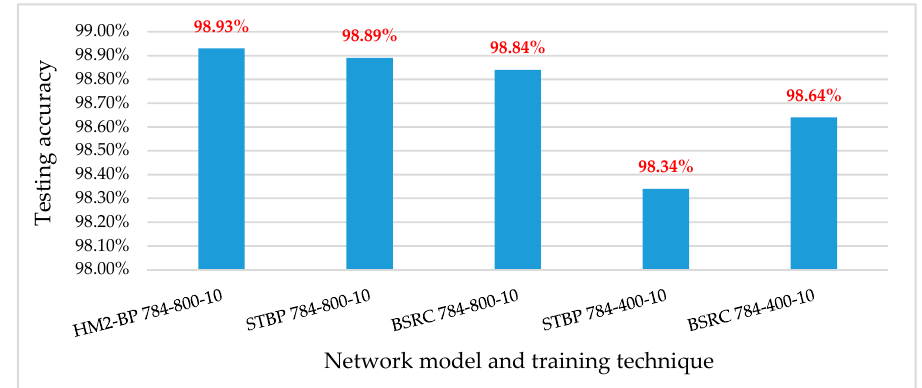
Figure 10. Accuracy of two SNN structures trained by three different modeling and training techniques: HM2-BP, STBP, and BSRC (Proposed).